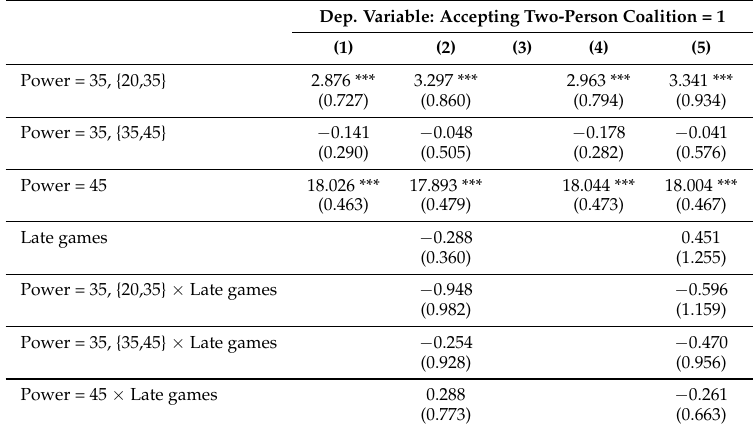
Table A6. Probability of accepting a two-person